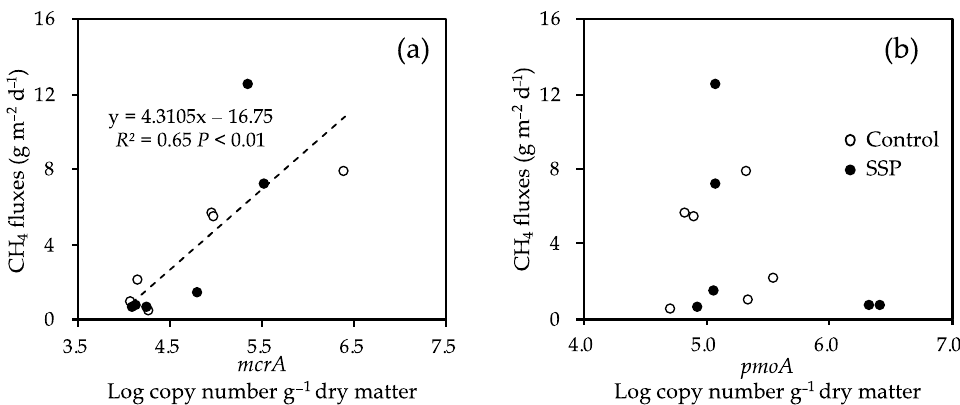
Figure 3. Dependency of CH 4 fluxes on the abundance of mcrA ( a ) and pmoA ( b ) genes across different treatments. Treatments were defined as in Figure 1. SSP: superphosphate.